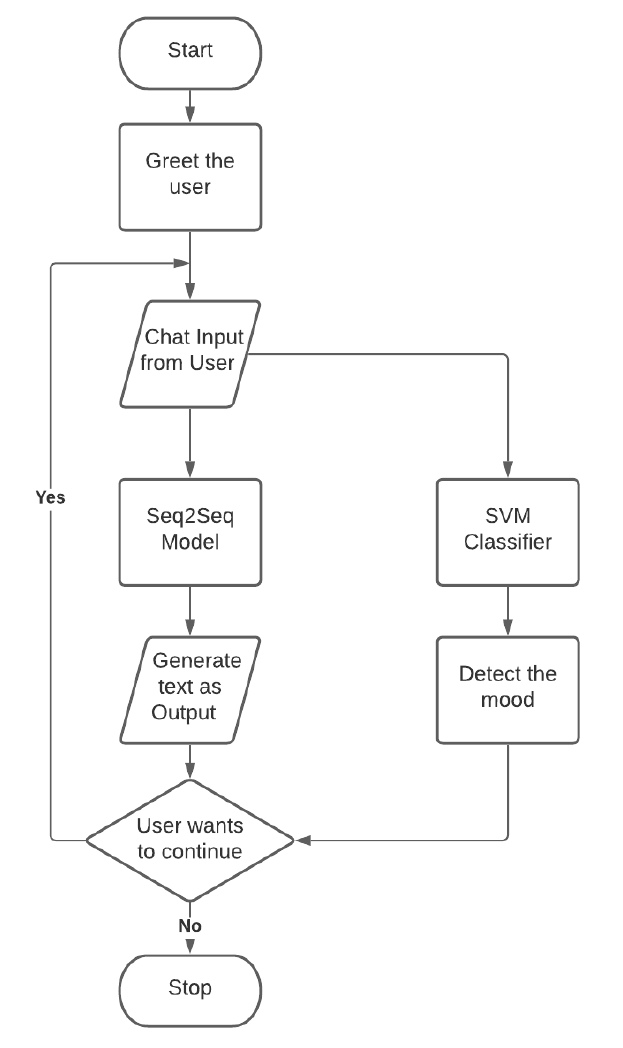
Fig 4 : Flowchart of the model